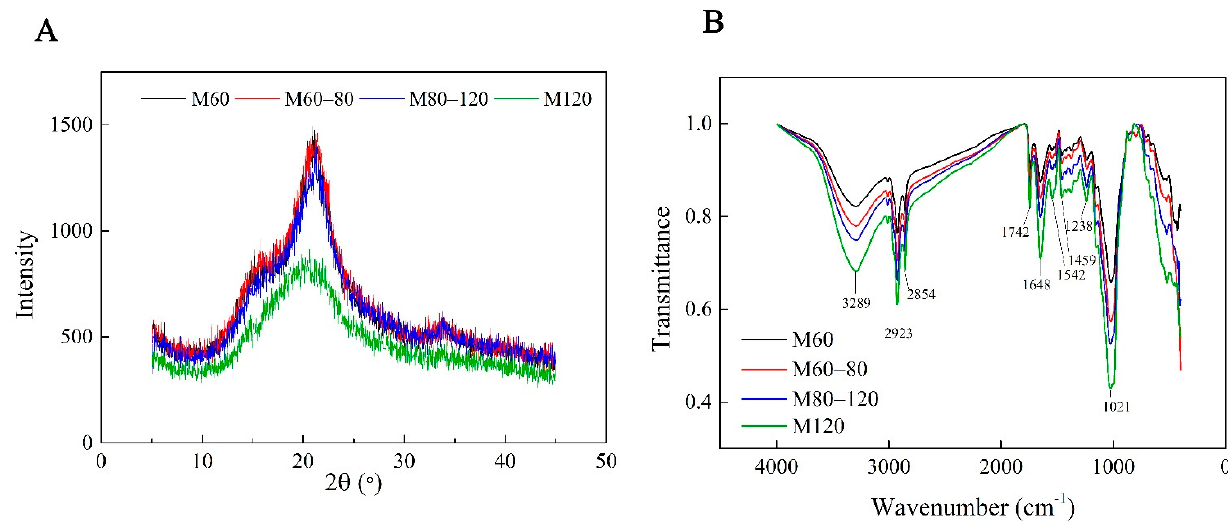
Figure 3. The X-ray diffraction (XRD) ( A ) patterns and Fourier-transform infrared (FTIR) ( B ) spectra of the foxtail millet bran powder with different particle sizes. Table 4. The crystallinity, peak temperature, and enthalpy of the foxtail millet bran powder.